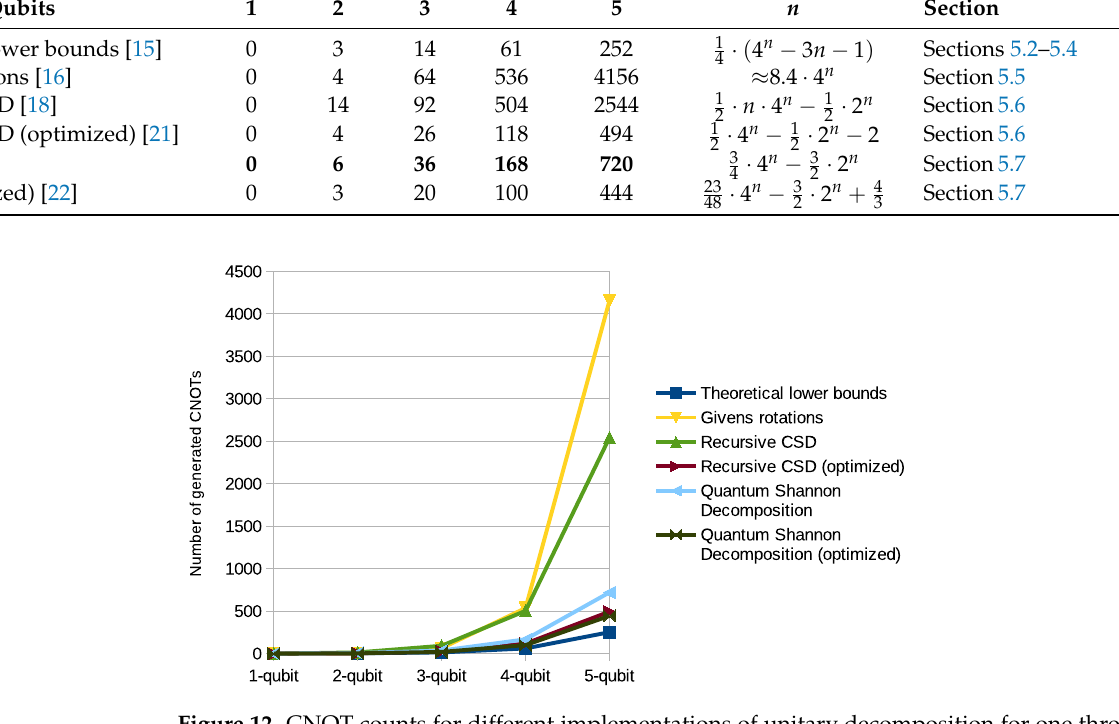
Figure 12. CNOT counts for different implementations of unitary decomposition for one through five-qubit gates. The chosen algorithm is shown in